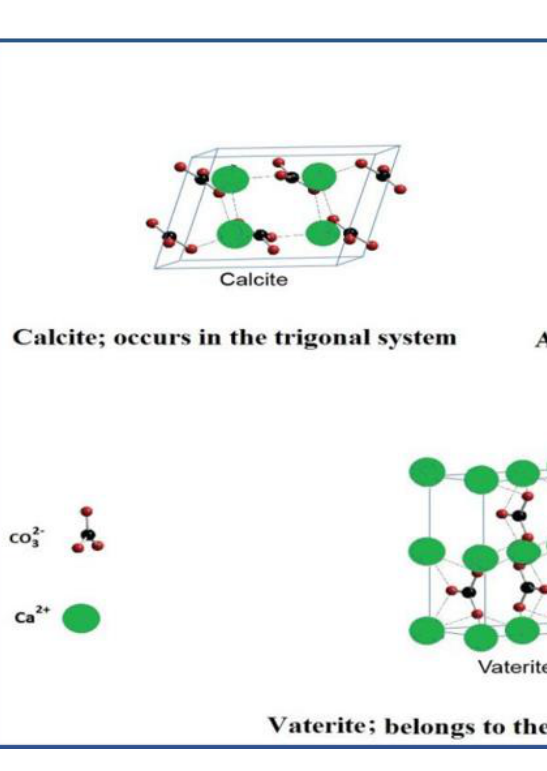
Figure 1. The three polymorphic forms of calcium carbonate extracted and modified from Dizaj et al. [6].